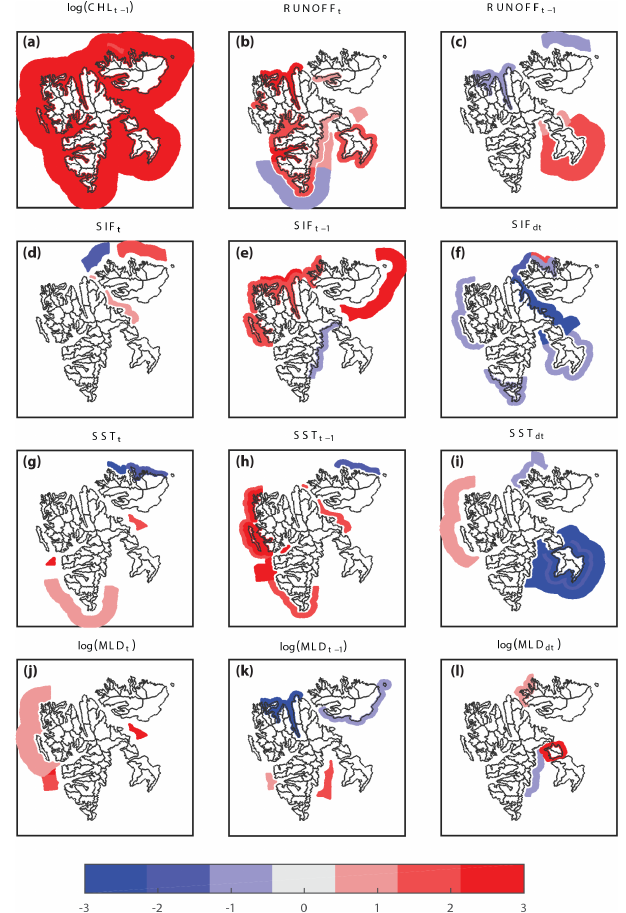
Figure 2. Regional significance of environmental variables and their association with the predicted chlorophyll a concentrations within 0–10, 10–20 and 20–50km from the coast: CHL during pre- vious 8d period (a) ; glacier runoff, RUNOFF, during the current and previous 8d period (b, c) ; current, previous and change in sea- ice fraction, SIF ( d–f ; denoted by index t , t − 1 and d t ); sea-surface temperature, SST (g–i) ; and mixed-layer depth, MLD (j–l) . Posi- tive associations are indicated by red shades and negative by